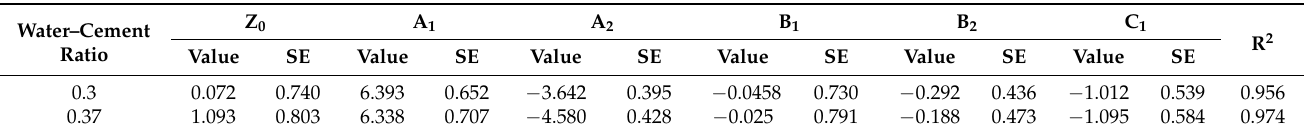
Table 6. Prediction equation fitting of concrete in elastic modulus.